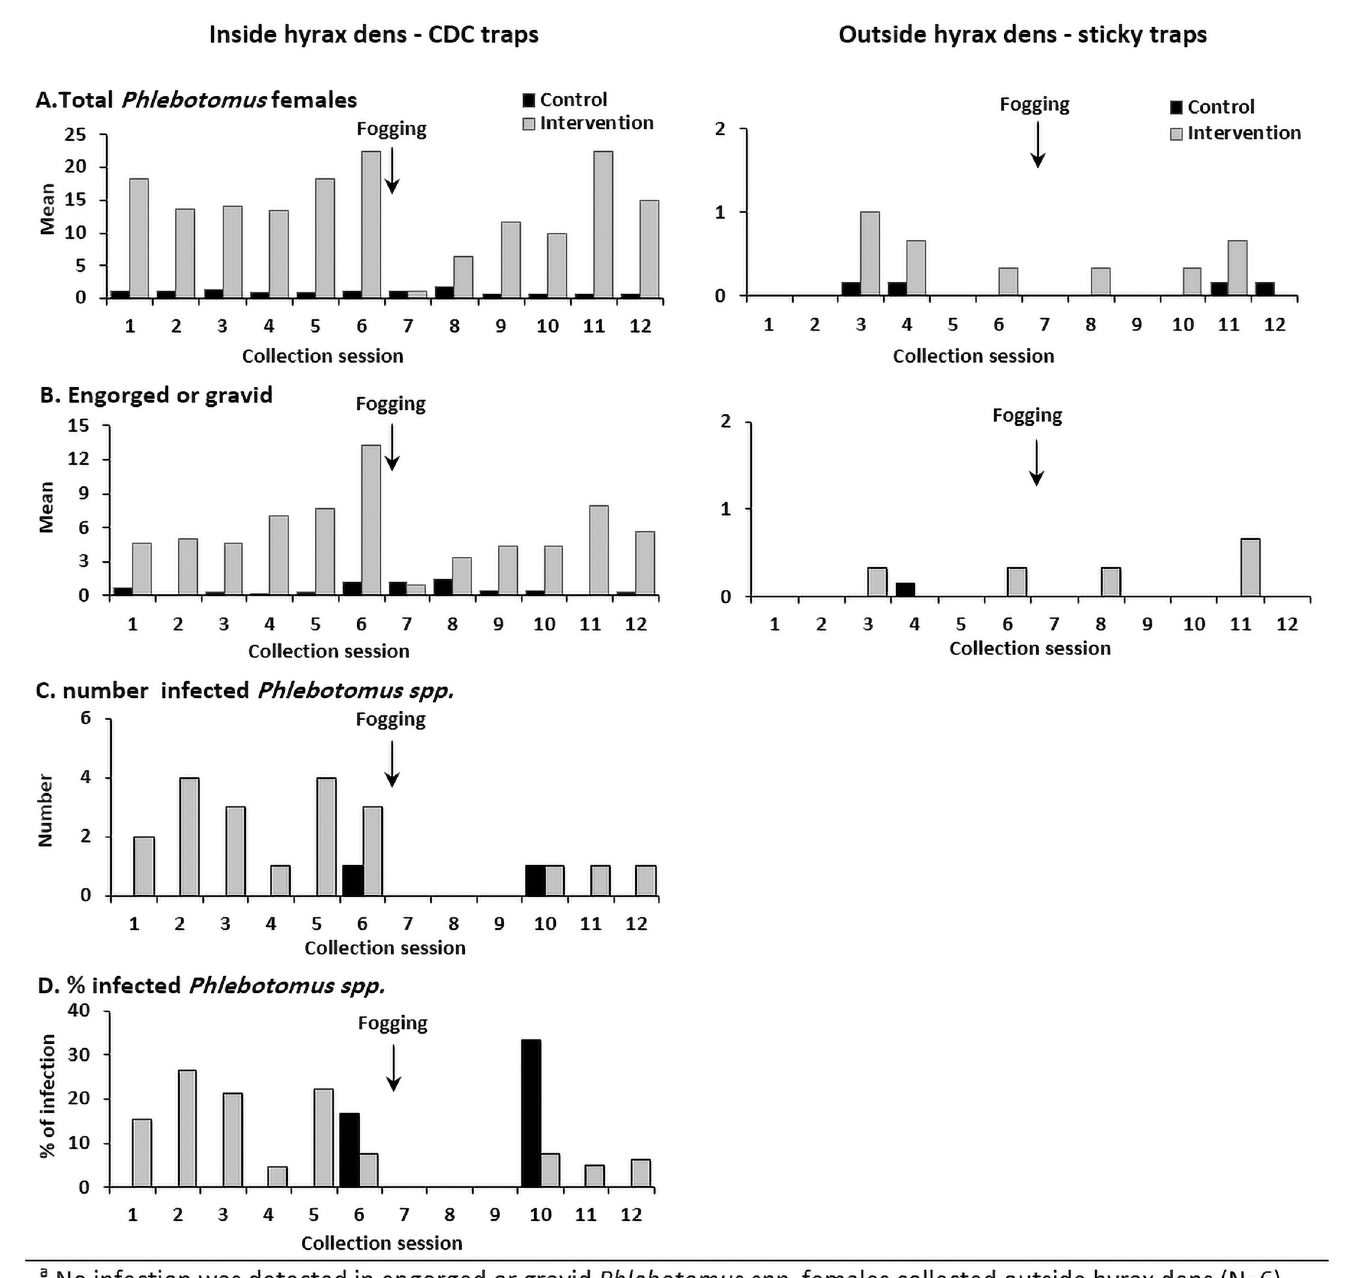
Fig 4. Density of Phlebotomus spp . females (A), engorged or gravid females (B) and total number (C) and percentage (D) of infected females a collected inside (right) and outside (left) hyrax dens in the intervention (Intervention site) and control (Control site) sites by collection session b , Tayasir, Palestine, June— September 2019 (S2 Data). a No infection was detected in engorged or gravid Phlebotomus spp . females collected outside hyrax dens (N = 6). b All collection sessions occurred weekly. The 7 th collection session occurred 36 hours after the fogging intervention.